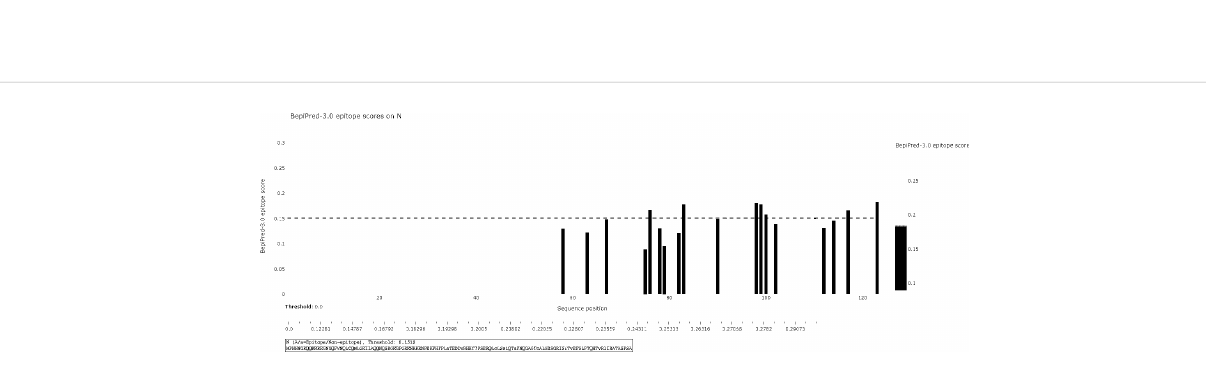
FIGURE 5 B-cell epitope prediction using the BepiPred-3.0 online software. The porcine reproductive and respiratory syndrome virus (PRRSV) N protein was subjected to BepiPred-3.0 prediction software and the yellow color represents high scores, suggesting the location of the B-cell epitope.